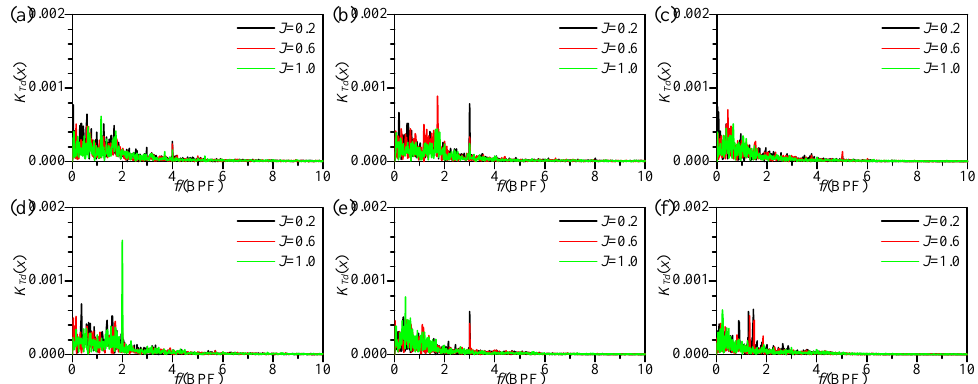
Figure 18. Frequency domain curves of fluctuation component of K Td ( x ) . (from ( a – f ) corresponding to PJP model ID 2 to